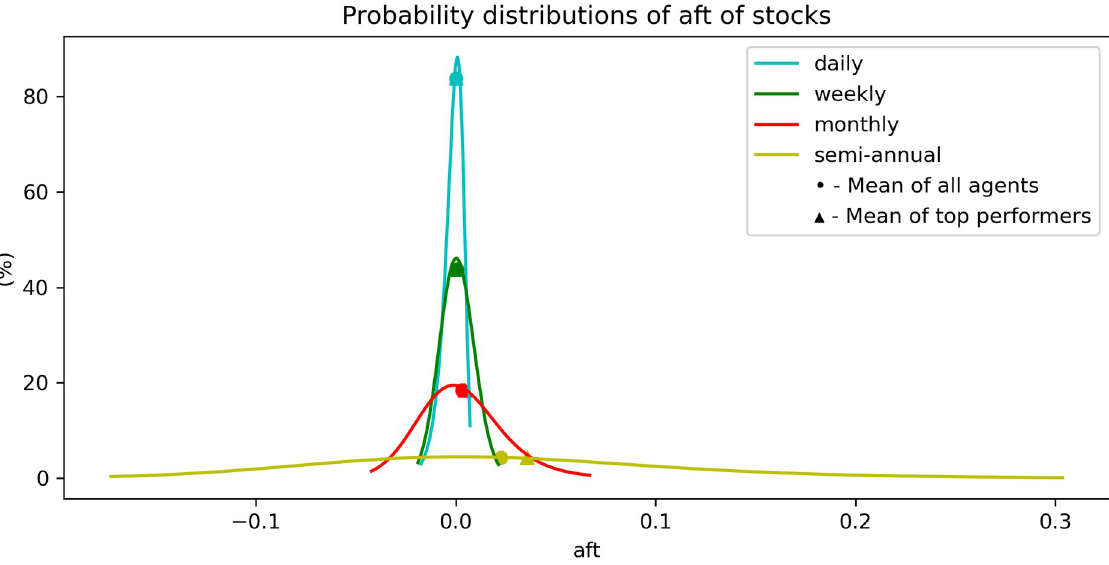
Fig 7. Probability distribution of the antifragility A for stocks for different time-scales. The dashed line represents the mean antifragility of the set of ‘top-performers’. We observe that the mean A of ‘top-performers’ is only greater than the mean A in the daily timescale.